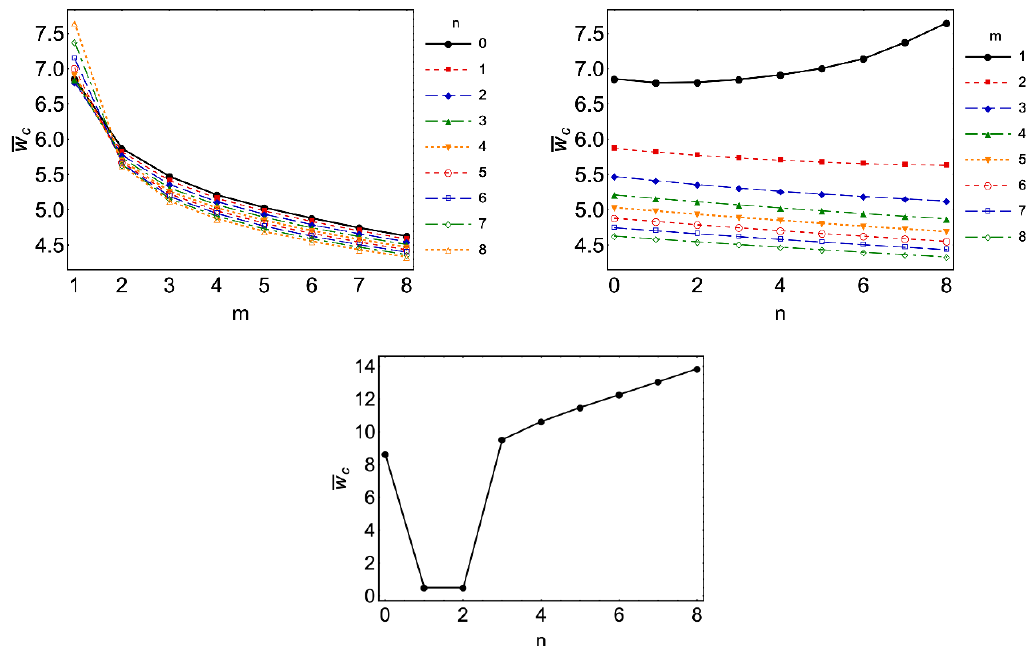
Figure 3 . The pseudo-thermalization time w c for n; m 2 f 0 ; (cid:1) (cid:1) (cid:1) ; 8 g and (cid:14) c = 10 (cid:0) 6 . The top left panel shows w c as a function of m with the lines corresponding to di(cid:11)erent values of n . The top right panel shows w c as a function of n with the lines corresponding to di(cid:11)erent values of m . The bottom panel shows w c as a function of n for the case m =